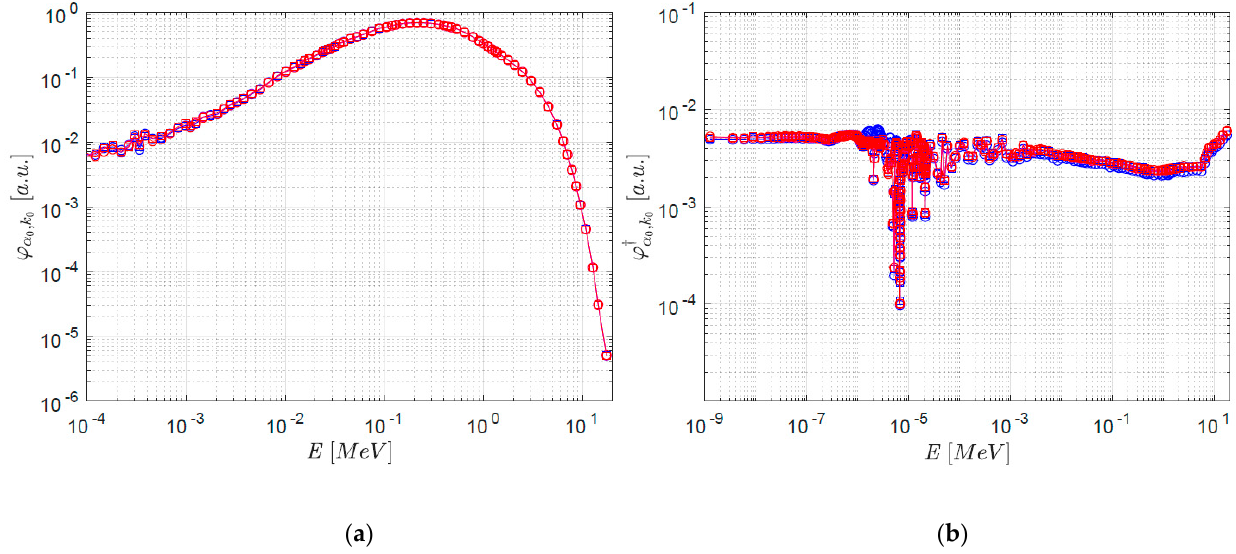
Figure 2. Problem I, sub-critical configuration, direct ( a ) and adjoint ( b ) fundamental distributions according to the α -(blue) and k -(red) eigenvalue formulations, with (squares) and without (circles) delayed